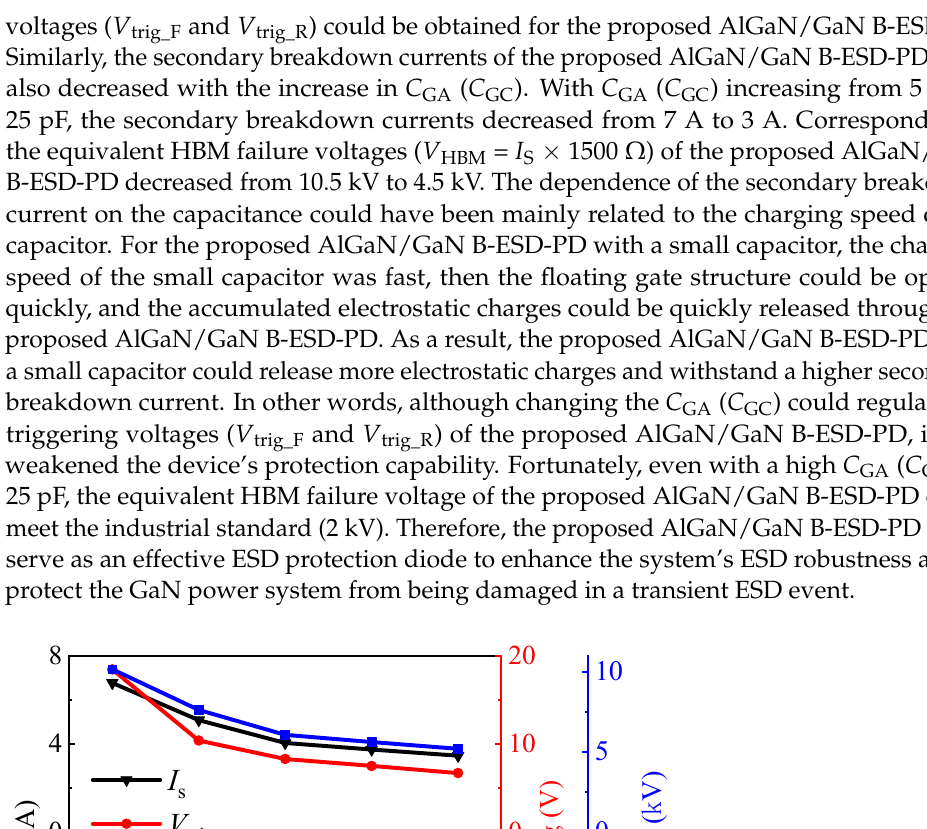
A C GA Figure 8. The schematic structure, equivalent circuit ( a ) and bidirectional TLP I–V characteristics ( b ) of the unidirectional AlGaN/GaN ESD protection diode. In order to make a comprehensive comparison, the TLP I–V characteristics of the pro- posed AlGaN/GaN B-ESD-PD with different C G1 ( C G2 ) values were also investigated. First, the leakage current and TLP I–V characteristics of the two reverse-series connected E - mode p-GaN HEMTs with two gate electrodes connected to the floating ohmic electrode through C G1 and C G2 are presented in Figure 9. The device is called diode 1 in the following work, and its equivalent circuit is shown in the inset of Figure 9a. As indicated in Figure